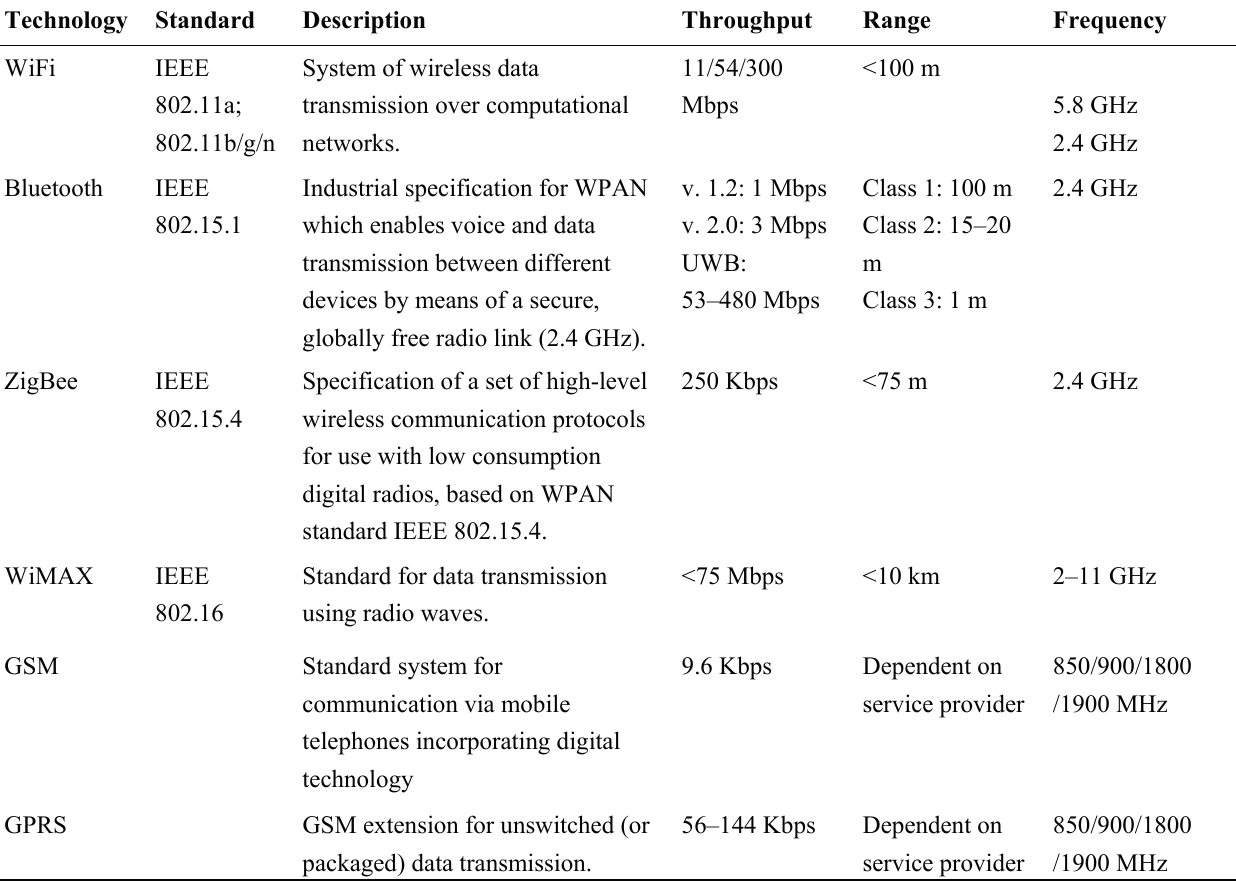
Table 2. Wireless communication technologies